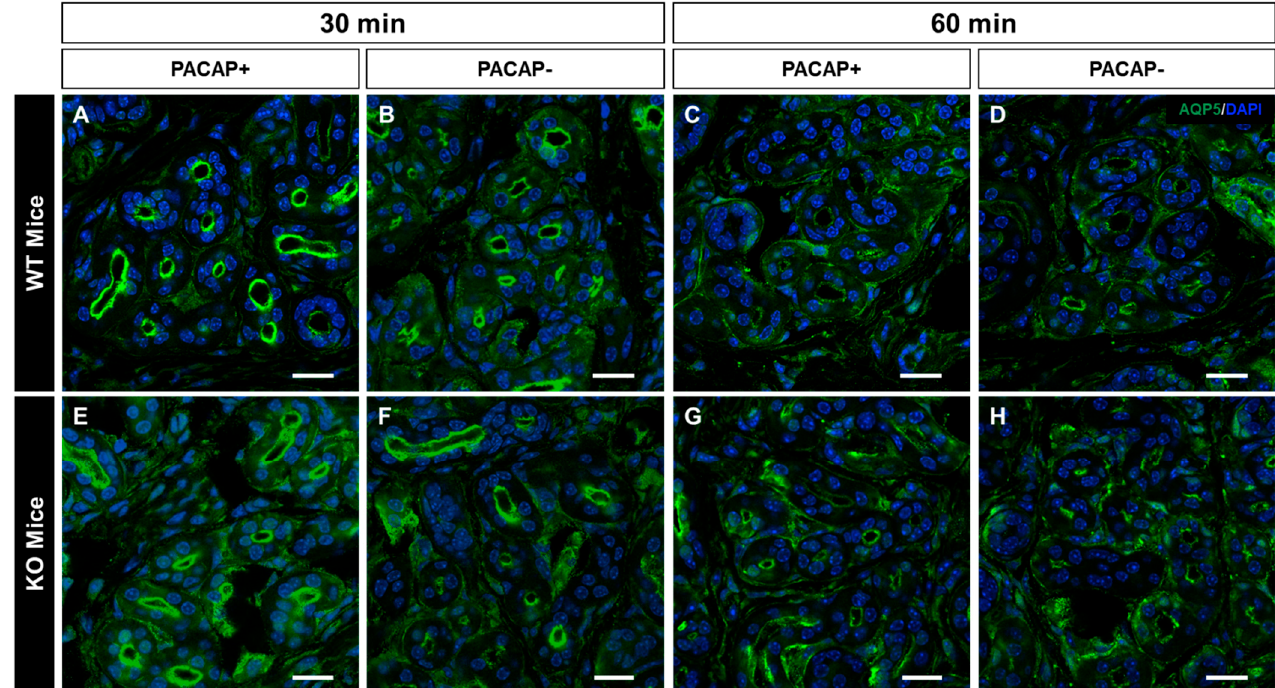
Figure 3. Changes in the intracellular localization of AQP5 in WT mice and KO mice after PACAP addition. Mouse skins were immunostained with AQP5 (green) and counter stained with DAPI (nuclei). Representative confocal micrographs of mouse eccrine gland transfected with ( A ) 30 min after PACAP treatment, ( B ) 30 min after vehicle treatment, ( C ) 60 min after PACAP treatment, ( D ) and 60 min after vehicle treatment in WT mice. Representative confocal micrographs of mouse eccrine gland transfected with ( E ) 30 min after PACAP treatment, ( F ) 30 min after vehicle treatment, ( G ) 60 min after PACAP treatment, ( H ) and 60 min after vehicle treatment in PAC1R KO mice. Scale bar = 10 μ m.